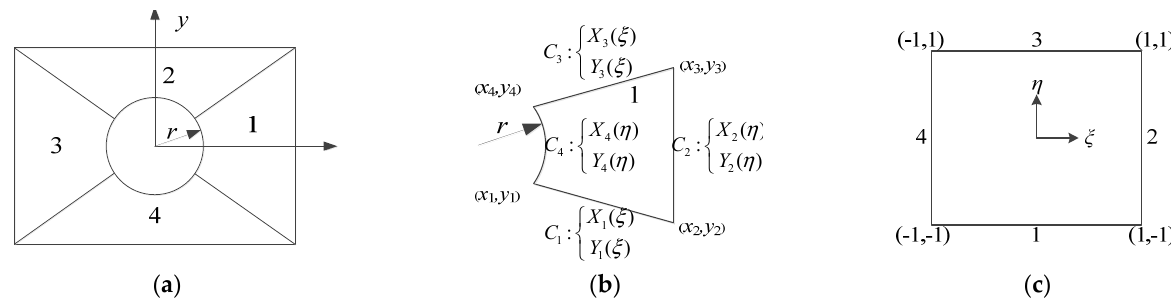
Figure 3. Discretization of rectangular plate with circular cutout: ( a ) geometric region; ( b ) closed quadrilateral region; ( c ) calculation region.